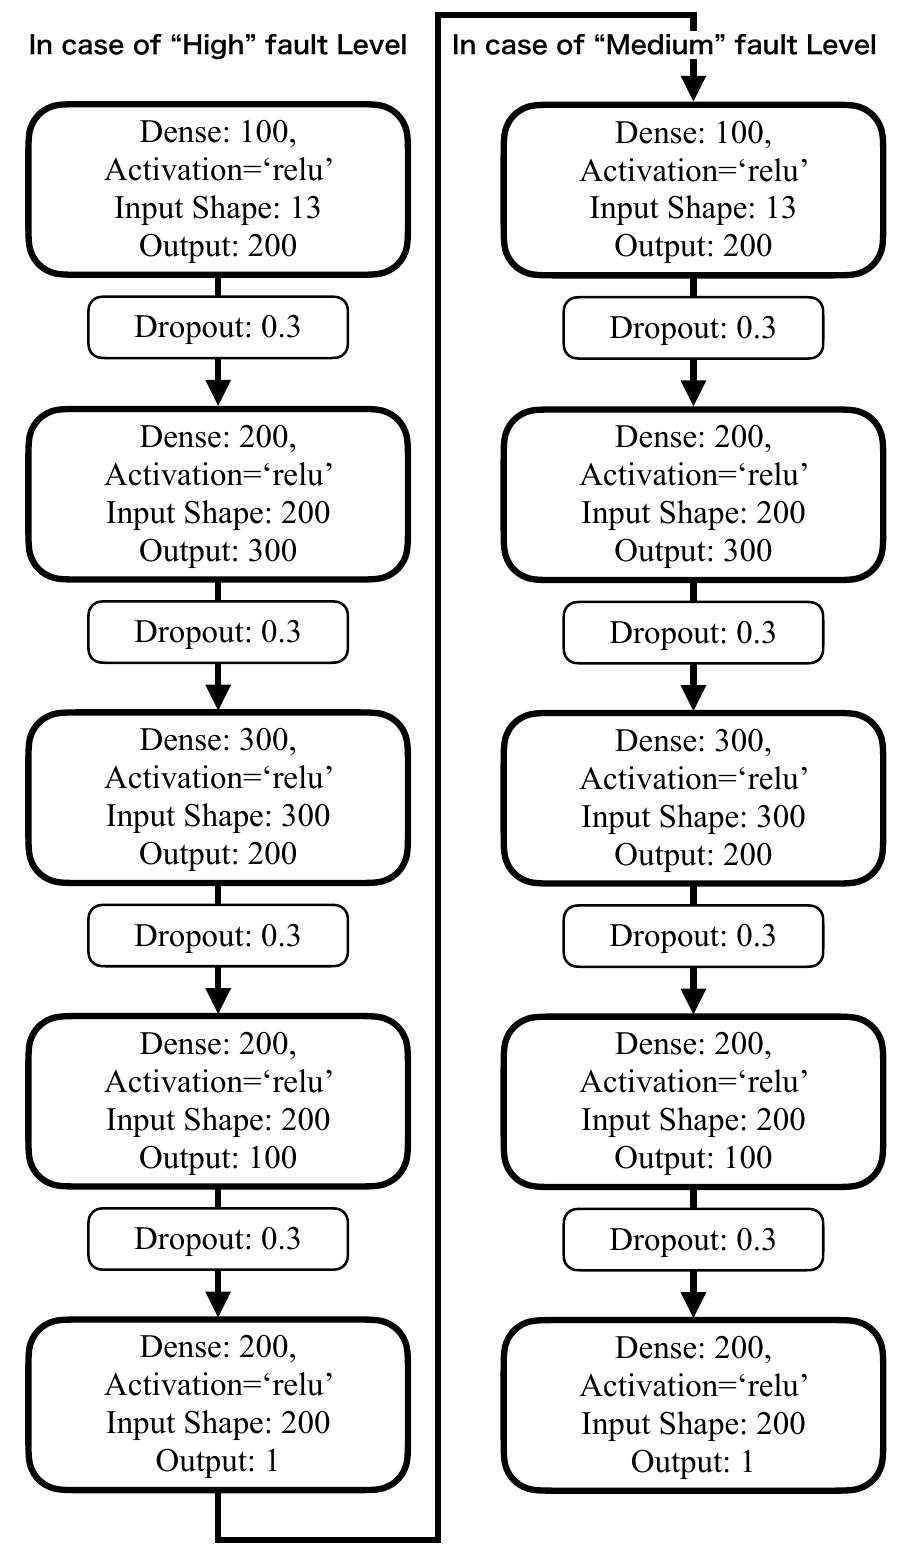
Figure 3. The workflow of estimation for each fault severity level by using the procedures of our deep learning